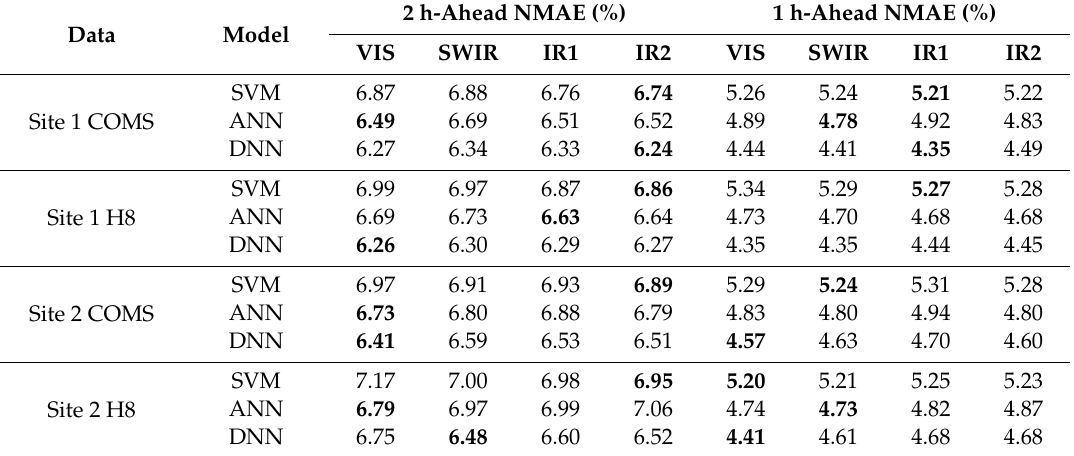
Figure 10. 2 h- and 1 h-ahead PV forecast results in NMAE (%) for each spectral band from COMS and H8 datasets using SVM, ANN, and DNN models based on setup 2. Table 8. NMAE results from 2 h- and 1 h-ahead PV power forecasts for COMS and H8 datasets using three forecast models (bold text indicates the lowest NMAE values for each forecast model).